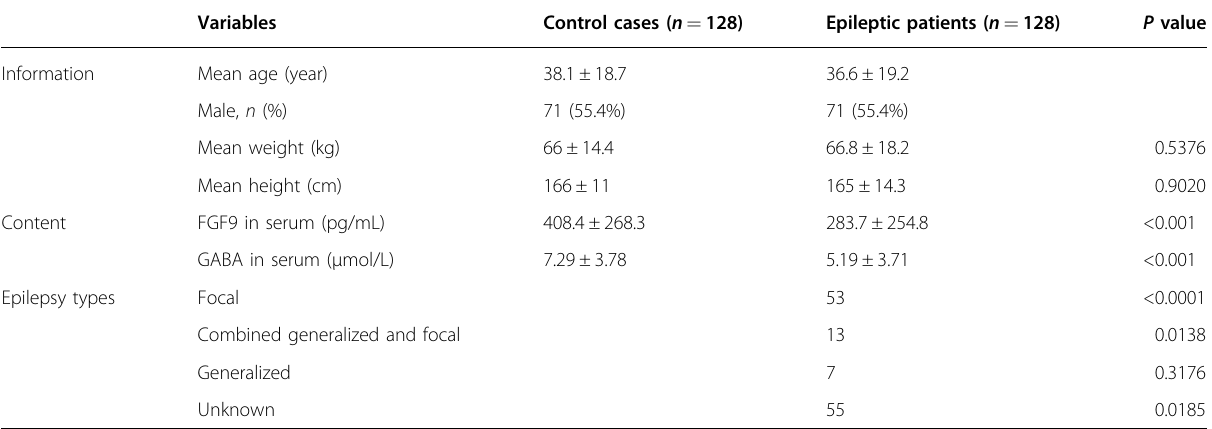
Table 2 The association between the expression of serum FGF9, GABA, and epileptic